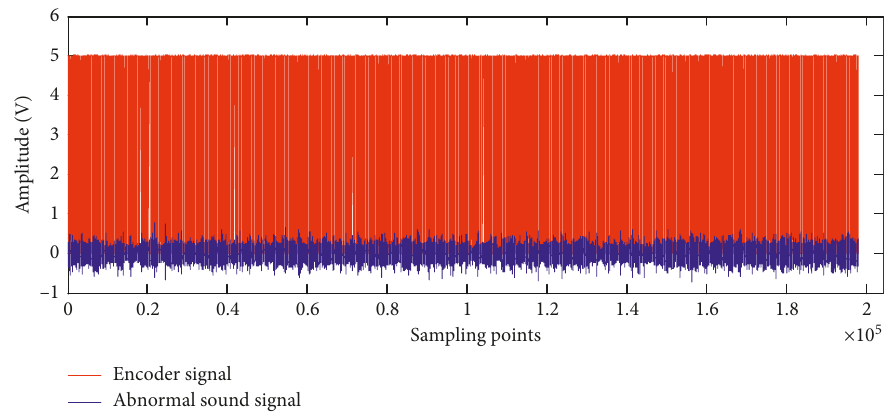
Figure 14: Abnormal noise signal of cylinder knocking and pulse signal under 1800r/min speed. Table 3: ρ ( W 1 , W 2 ) calculated from the first to the ninth rising edges.